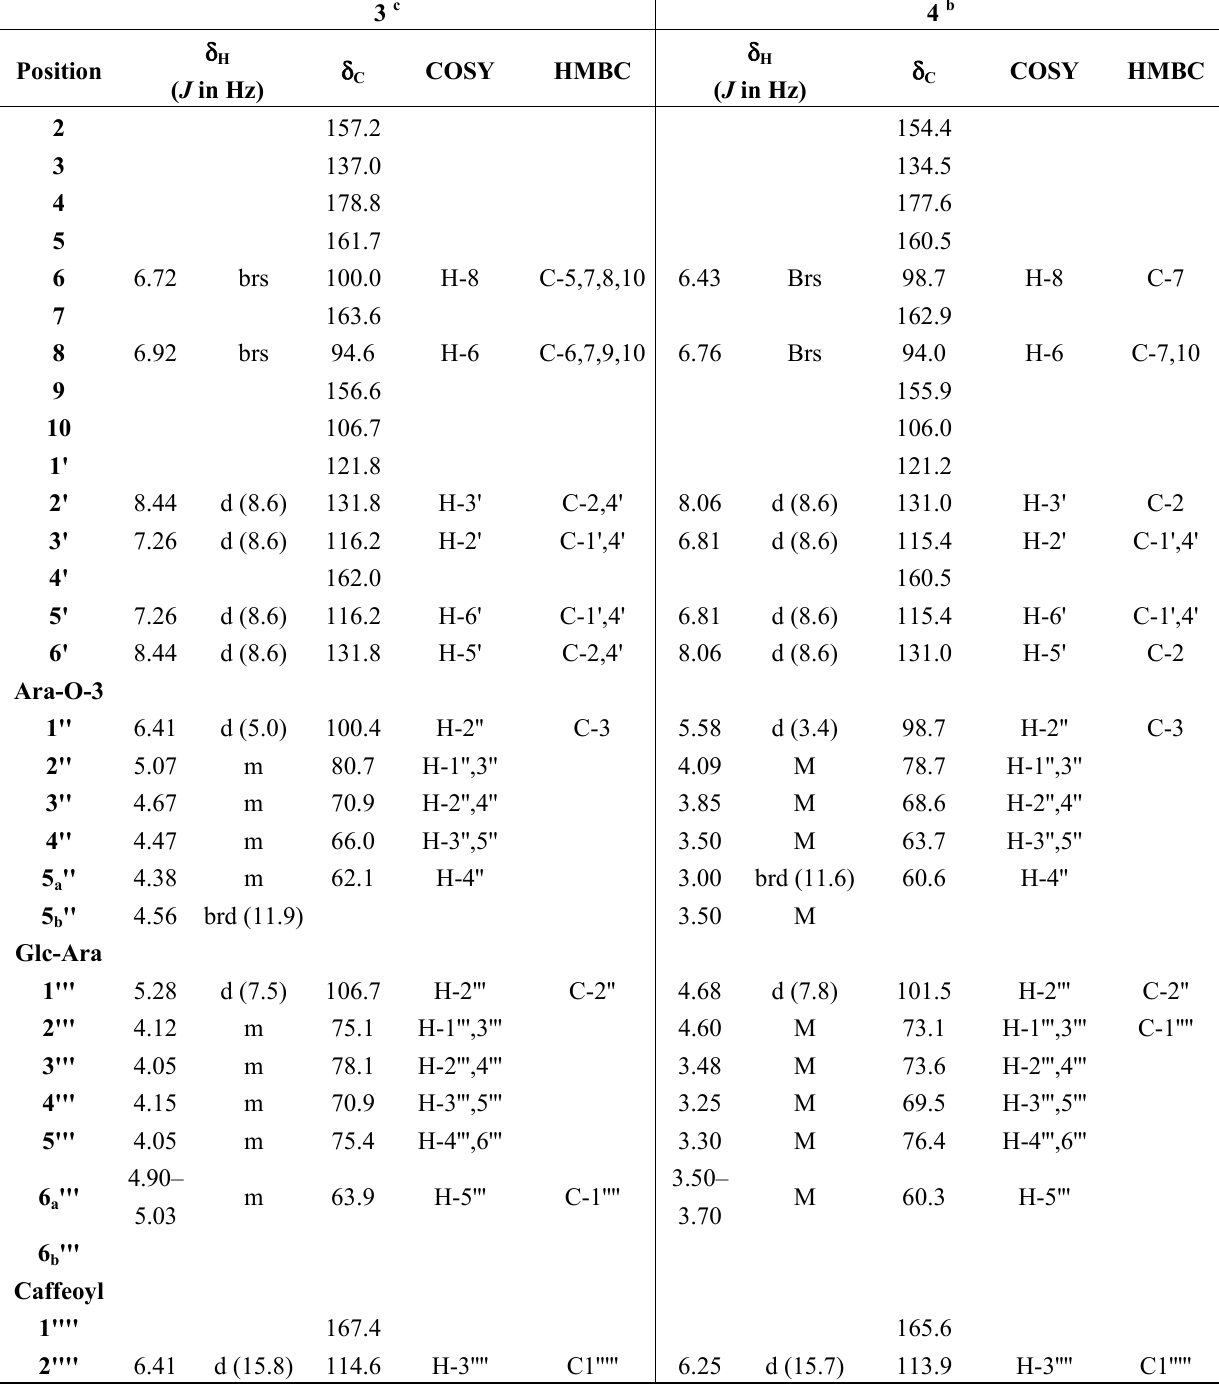
Table 2. 1 H-NMR, 13 C-NMR, and 2D-NMR spectral data for compounds 3 and 4